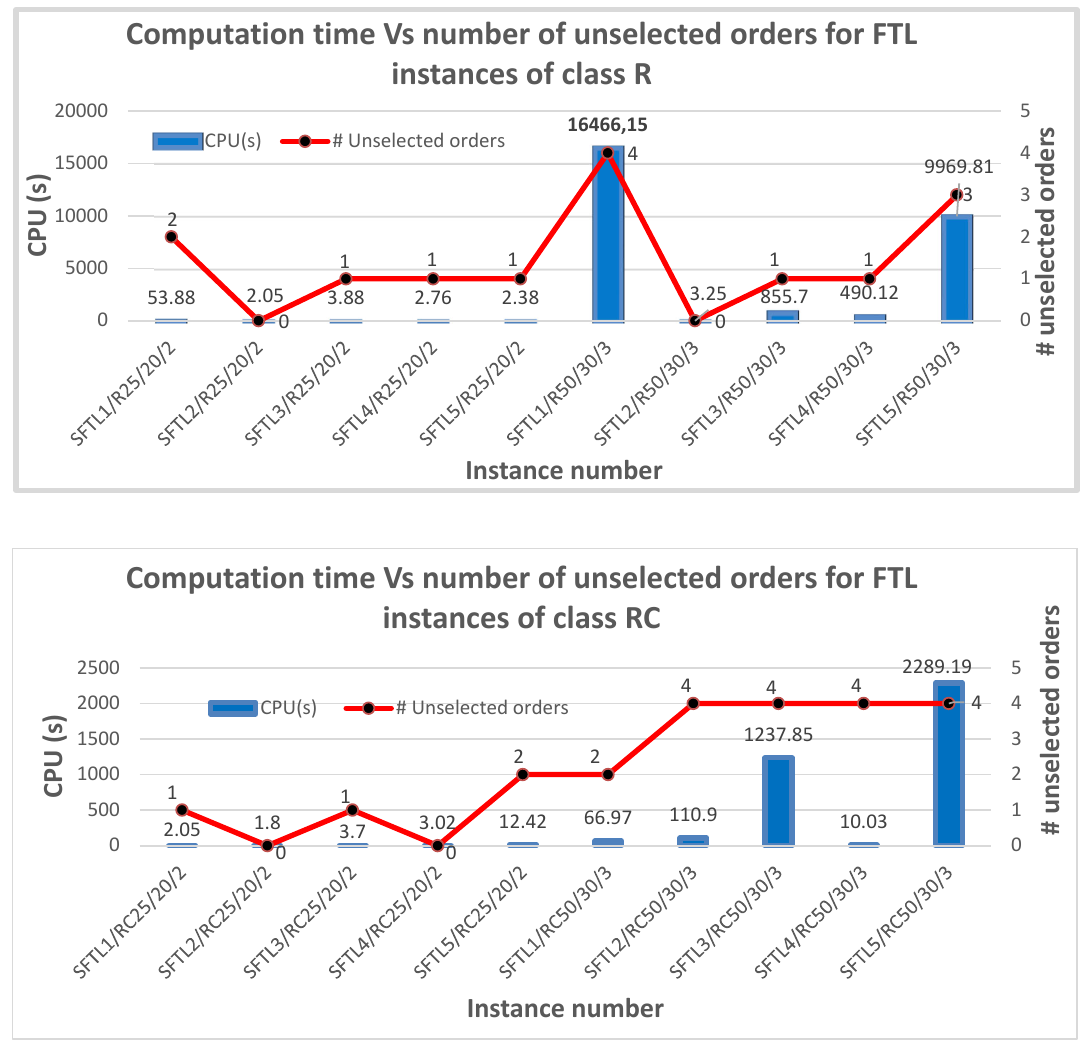
Fig. 3. Computation time vs. Number of unselected orders in the optimal solution from CPLEX for test